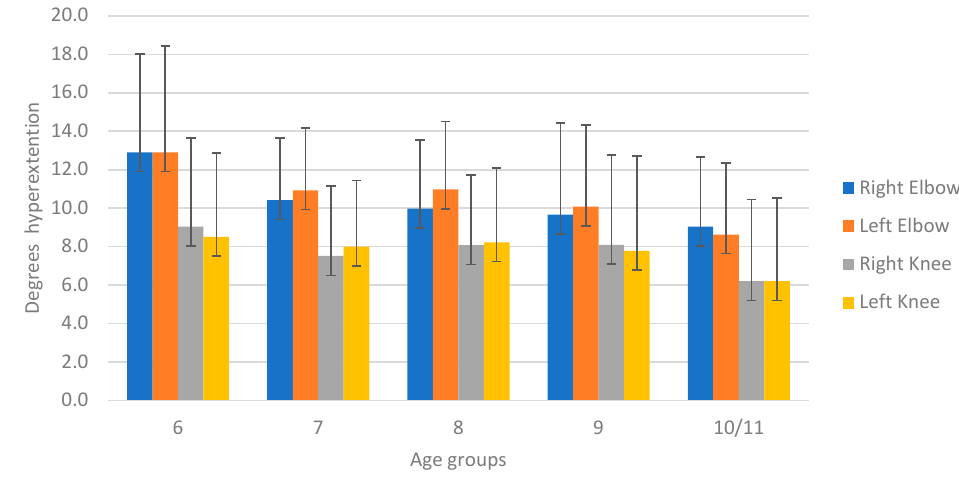
Figure 4. Percentage per Beighton classification for each age group. Based on the measured range of motion, there was a significant effect of age for all joints except for the left knee ( p = 0.14; see Figure 5). However, some fluctuations were seen between adjacent age groups for the MCP5 joints.